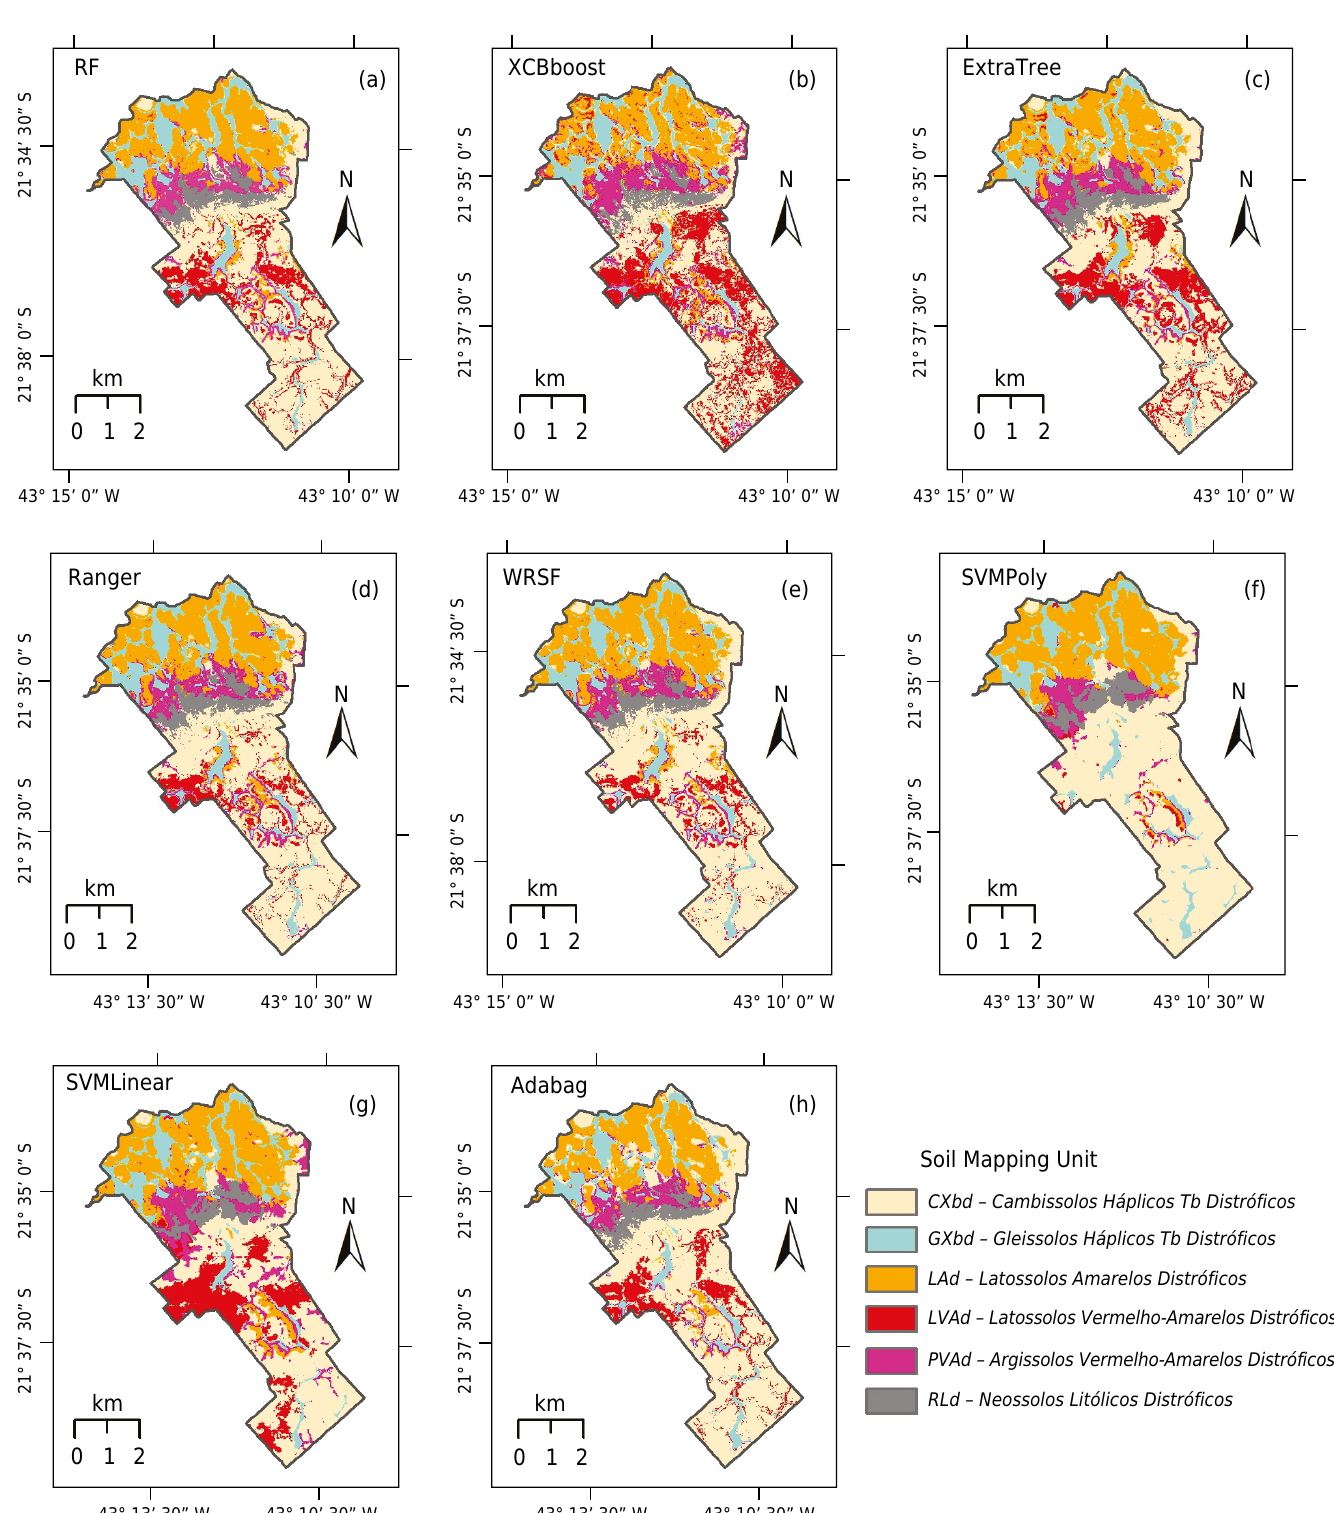
Figure 4. Maps generated by the classifiers RF (a), xgBoost (b), ExtraTree (c), Ranger (d), WSRF (e), SVMPoly (f), SVMLinear (g), and AdaBag (h). CXbd = Cambissolos Háplicos Tb Distróficos; GXbd = Gleissolos Háplicos Tb Distróficos; LAd = Latossolos Amarelos Distróficos; LVAd = Latossolos Vermelho-Amarelos Distróficos; PVAd = Argissolos Vermelho-Amarelos Distróficos; RLd = Neossolos Litólicos